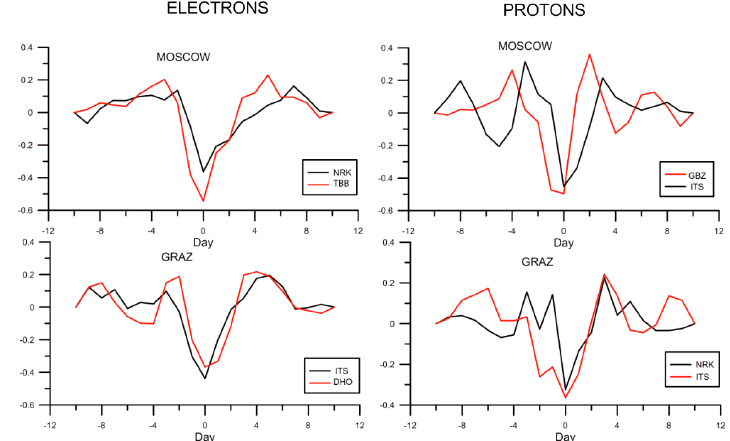
Figure 8. Cross-covariance functions for the average residual amplitude at nighttime of several signals receiving in the MOS and GRZ stations and the electron (left) and proton (right) fluxes (GOES). Y axis is the correlation coefficient.